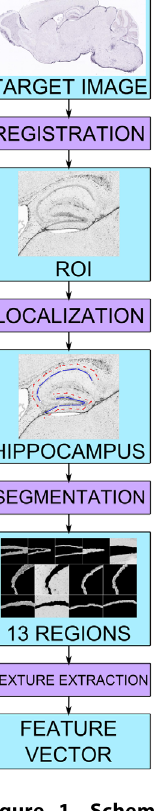
Figure 1. Schematic representation of the Hippo-ATESC pipeline.